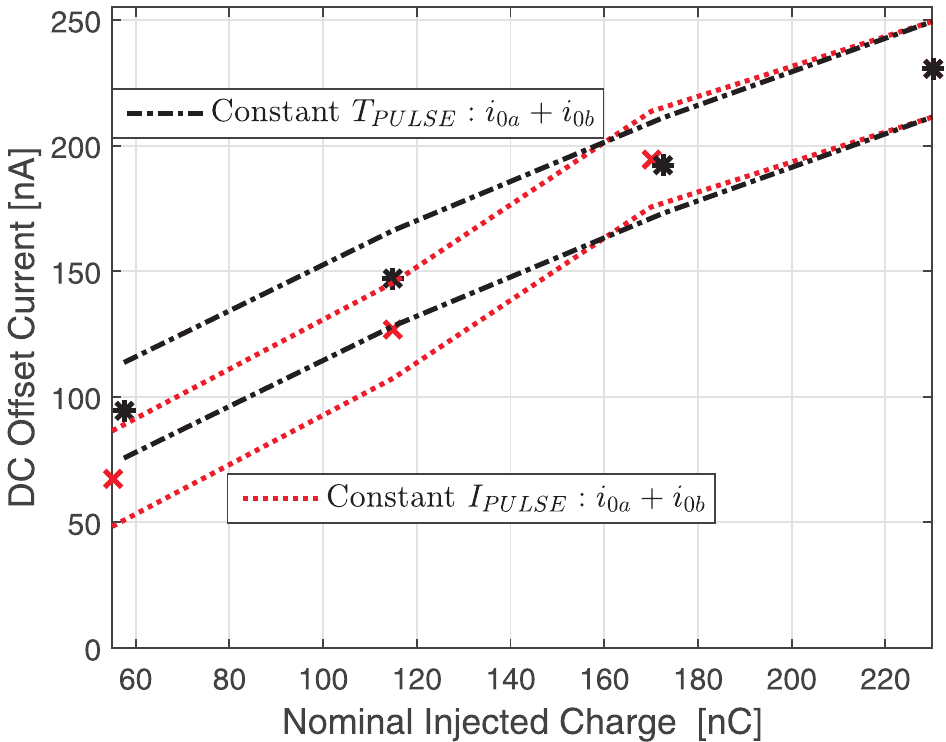
Figure 10. Hexagon HEXa and HEXb excitations according to the stimulation pattern in Figure 8. Nominal biphasic charge Q PULSE versus DC offset current ( ± 3 σ range around the average value defined by dashed and dash-dotted lines) for a constant current pulse I PULSE = I PULSE red lines around × ) and for constant pulse duration T PULSE = I PULSE lines around (cid:63) ). Multiple hexagon excitation (HEXa and HEXb) for a Hex Quasi-monopolar (HQ) stimulation pattern at 50